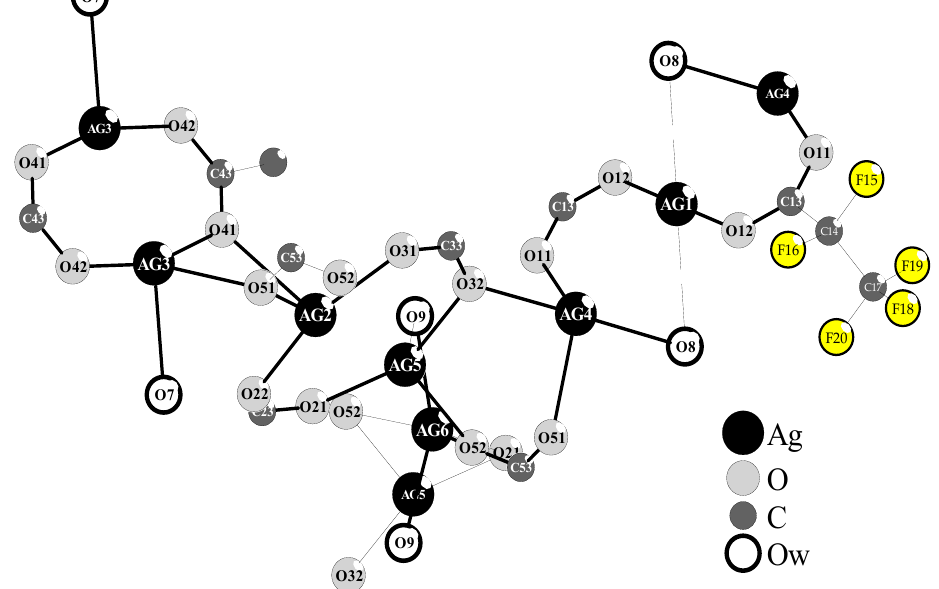
Figure 1. The scheme of the structure of [Ag 5 (O 2 CC 2 F 5 ) 5 (H 2 O) 3 ]. For clarity, the position of only one C 2 F 5 group has been presented (the full structure image is shown in the supplementary file: pp11a- 2000-sch_shape-13b3-checkcif).